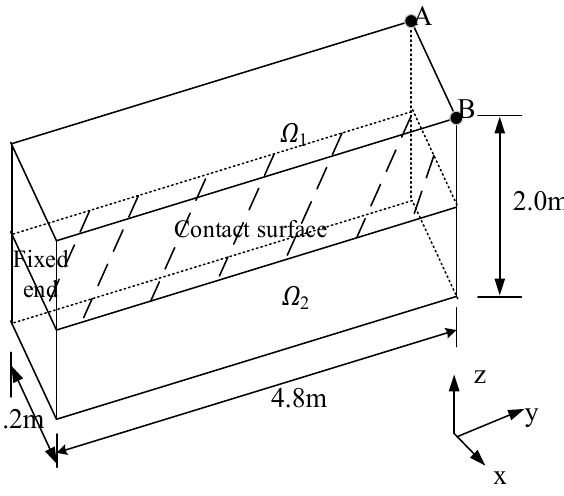
Figure 3. Two-block contact problem.